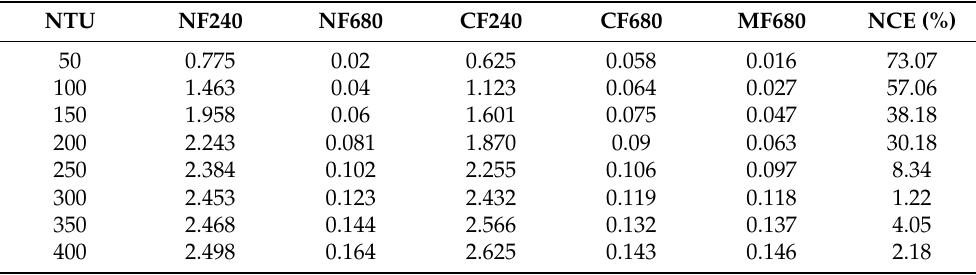
Figure 5. Calibration model of characteristic spectral absorbance and turbidity measurement. NF240 and NF680 are the model relationships between the turbidity and absorbance of turbidity standard solution at 240 and 680 nm, respectively. CF240 and CF680 are the model relationships between the turbidity of mixed liquids and absorbance at 240 and 680 nm, respectively. Table 3. Turbidity correction and measurement error